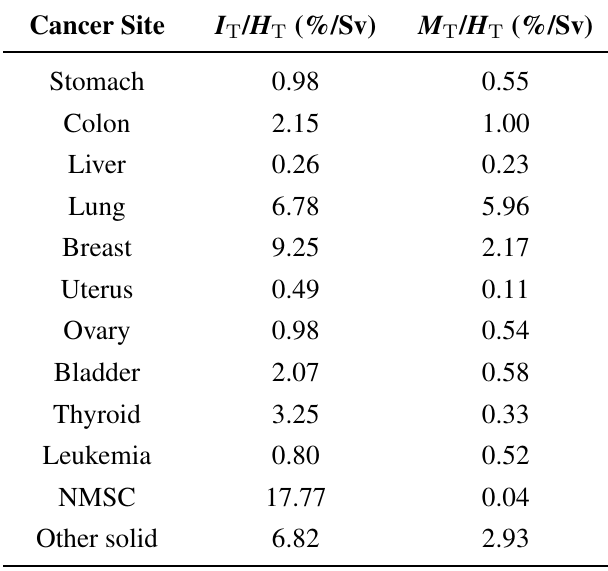
/ H , and mortality, M T T